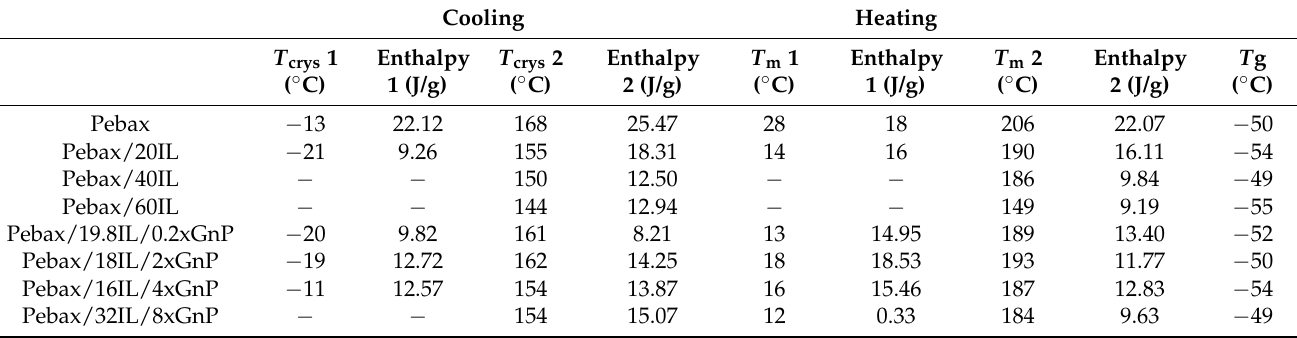
Table 3. Crystallization temperatures, T crys ; melting temperatures, T m ; and enthalpy, ∆ H , at 10 ◦ C/min.